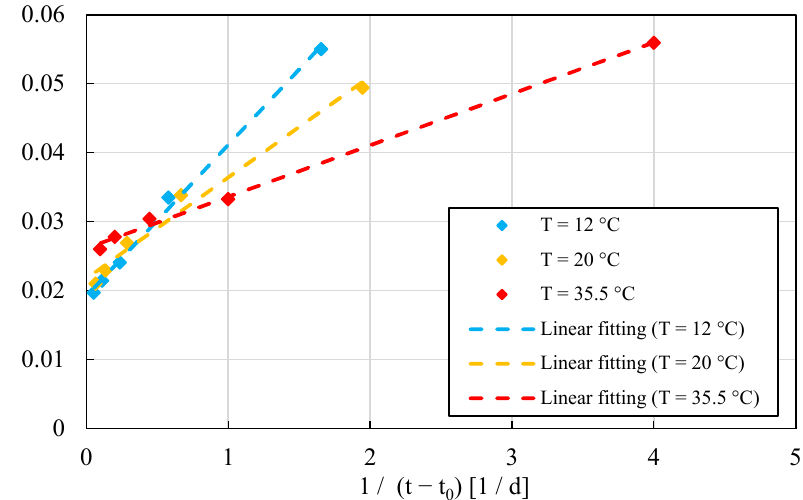
Figure 7. Determination of E a for OC-C30/37 series according to standard test (ASTM 1074). Each point corresponds to the mean value among 3 to 4 observations.